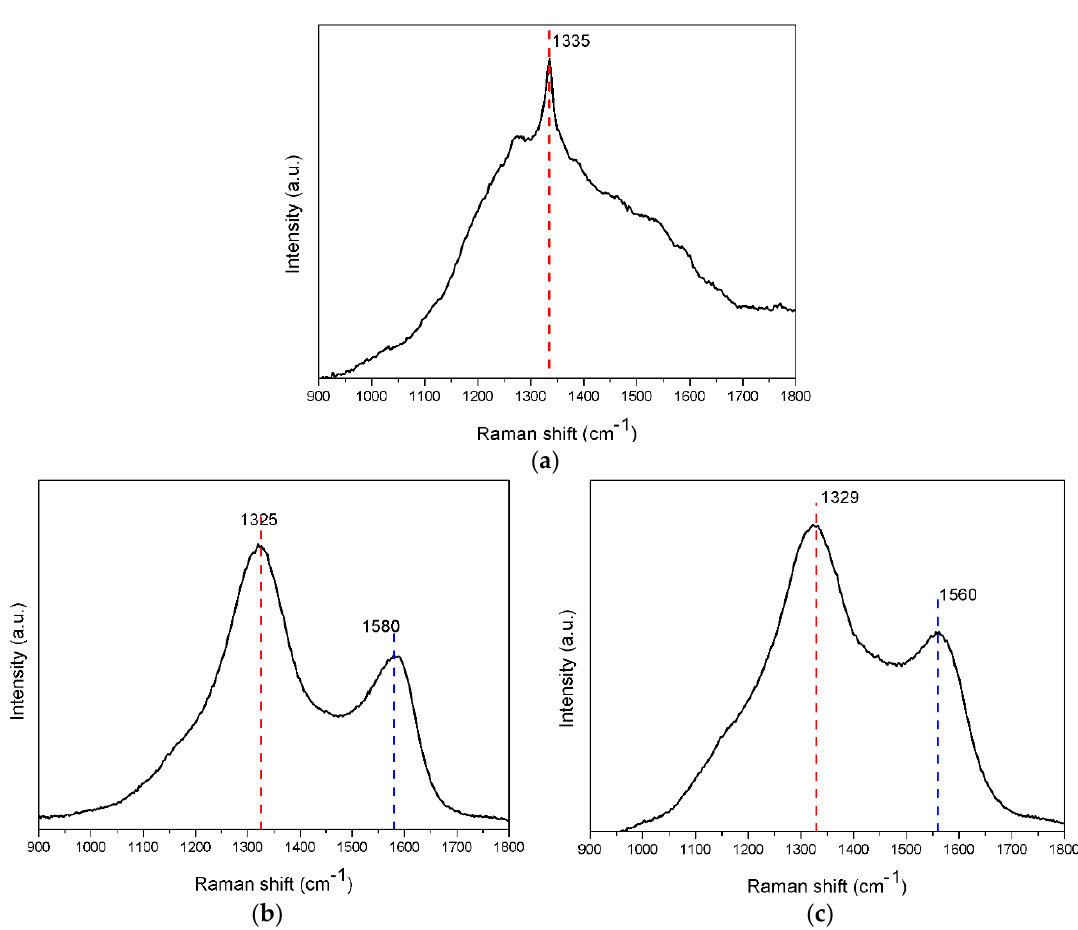
Figure 5. Raman spectrum of diamond coatings. ( a ) MCD; ( b ) NCD; ( c ) MCD/NCD.